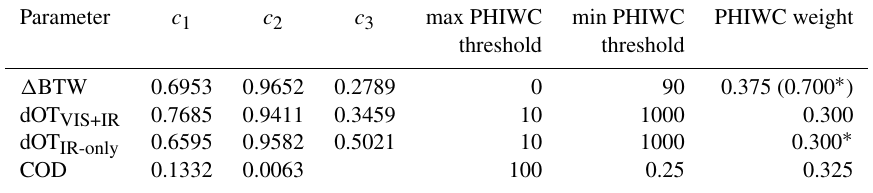
Table 2. Coefficients for deriving PHIWC values based on the fits shown by the magenta lines on Fig. 6. (cid:49) BTW, COD, and dOT values exceeding the max PHIWC threshold are assigned at PHIWC of 1.0. (cid:49) BTW and COD exceeding the min PHIWC Threshold are assigned a PHIWC of 0. Weights for Eq. (4) parameters are indicated in the last column. Weights for Eq. (5) parameters are indicated with an asterisk. Parameter c 1 c 2 c 3 max PHIWC min PHIWC PHIWC weight threshold threshold (cid:49) BTW 0.6953 0.9652 0.2789 0 90 0.375 (0.700 ∗ ) dOT VIS+IR 0.7685 0.9411 0.3459 10 1000 0.300 dOT IR-only 0.6595 0.9582 0.5021 10 1000 0.300 ∗ COD 0.1332 0.0063 100 0.25